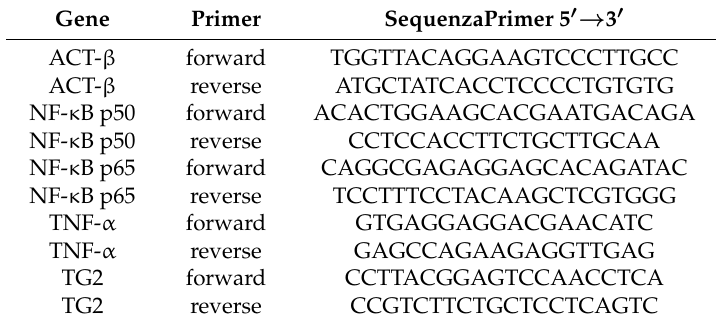
Table 1. Primer sequences used for quantitative real-time PCR analysis of mRNA transcript levels. Gene Primer SequenzaPrimer 5 (cid:48) → 3